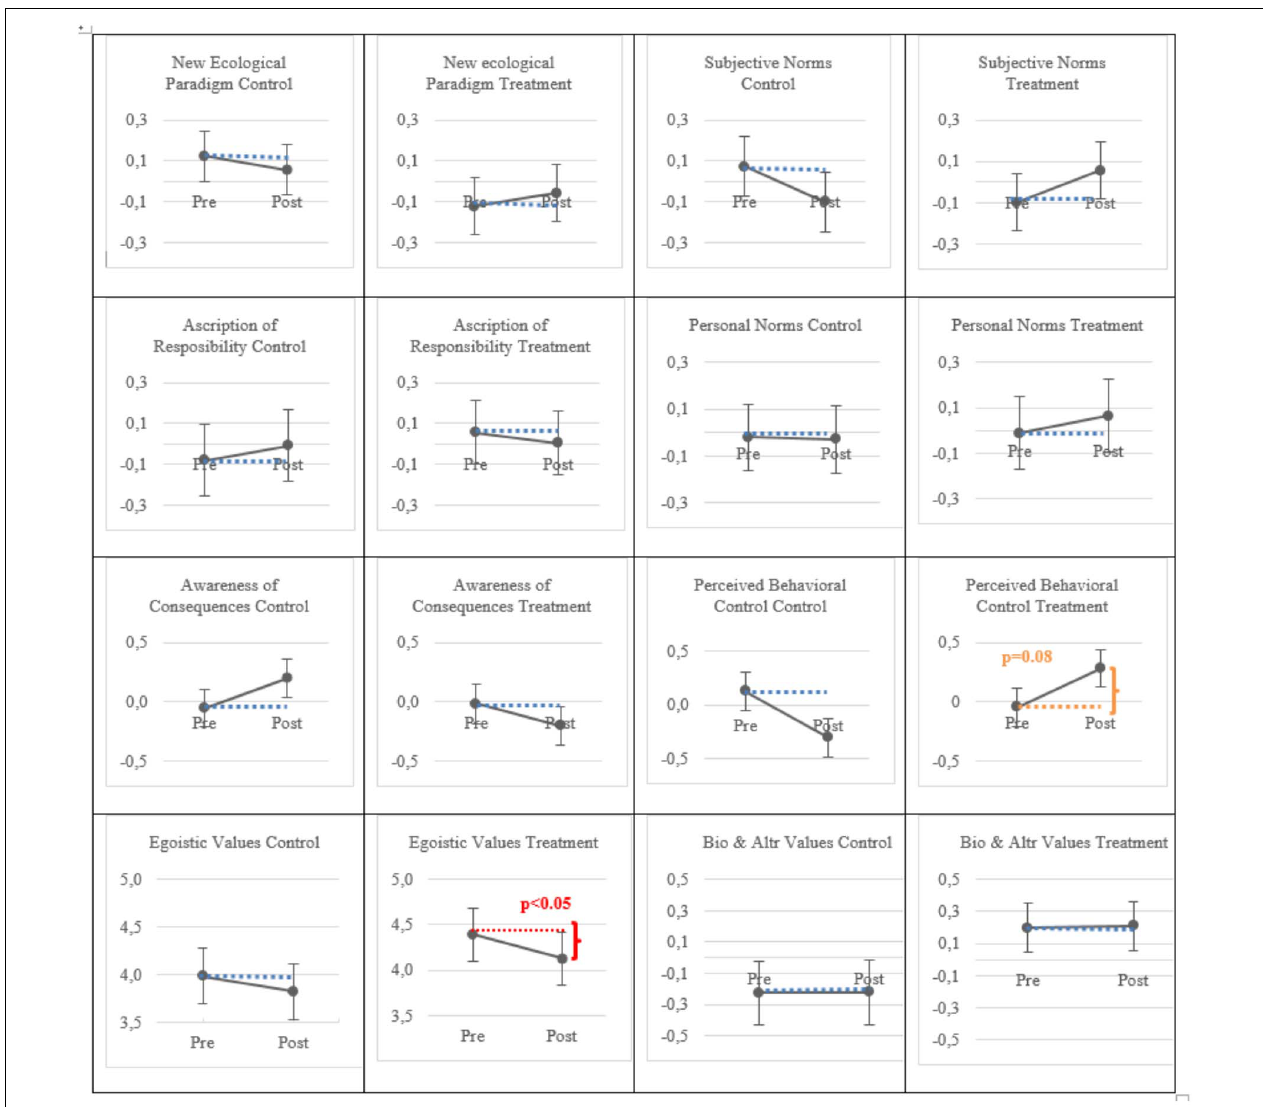
FIGURE 5 | Comparison between means of the pre and post survey sample within the control (non-EwE lecture) and treatment (EwE lecture). Blue dotted lines represent the difference between pre and post survey. A red dotted line indicates a significant difference at the p < 0.05 level; an orange dotted line shows a difference at the p < 0.1